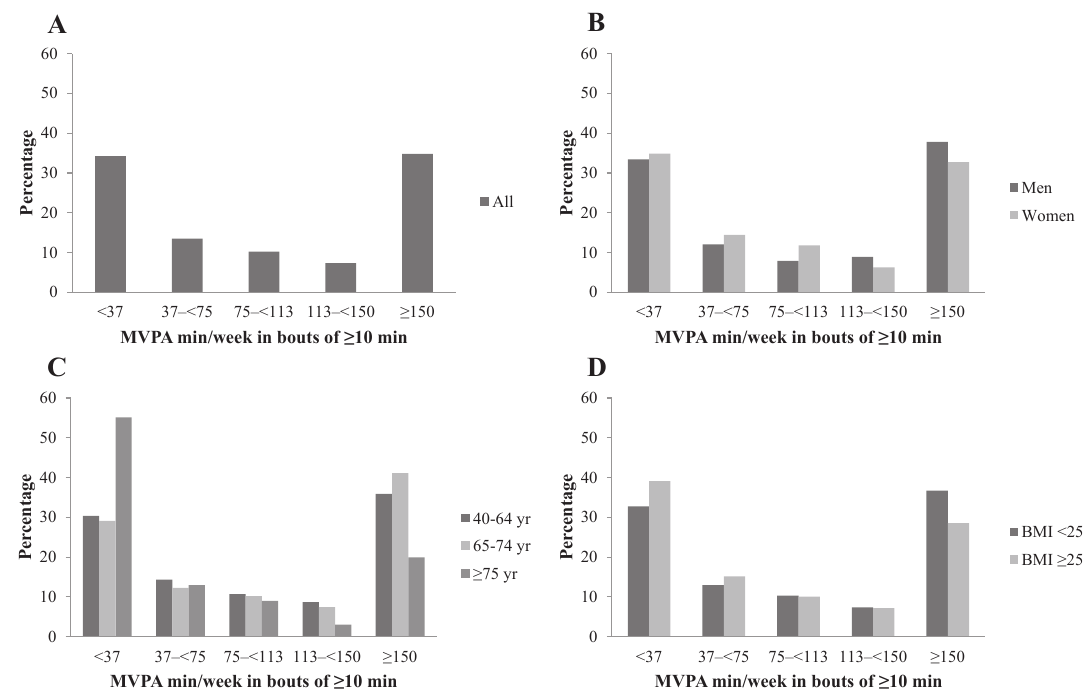
Figure 1. Distribution of participants accumulated de fi ned weekly MVPA in bouts of ; 10min by sex, age, and BMI. BMI, body mass index; MVPA, moderate-to-vigorous physical